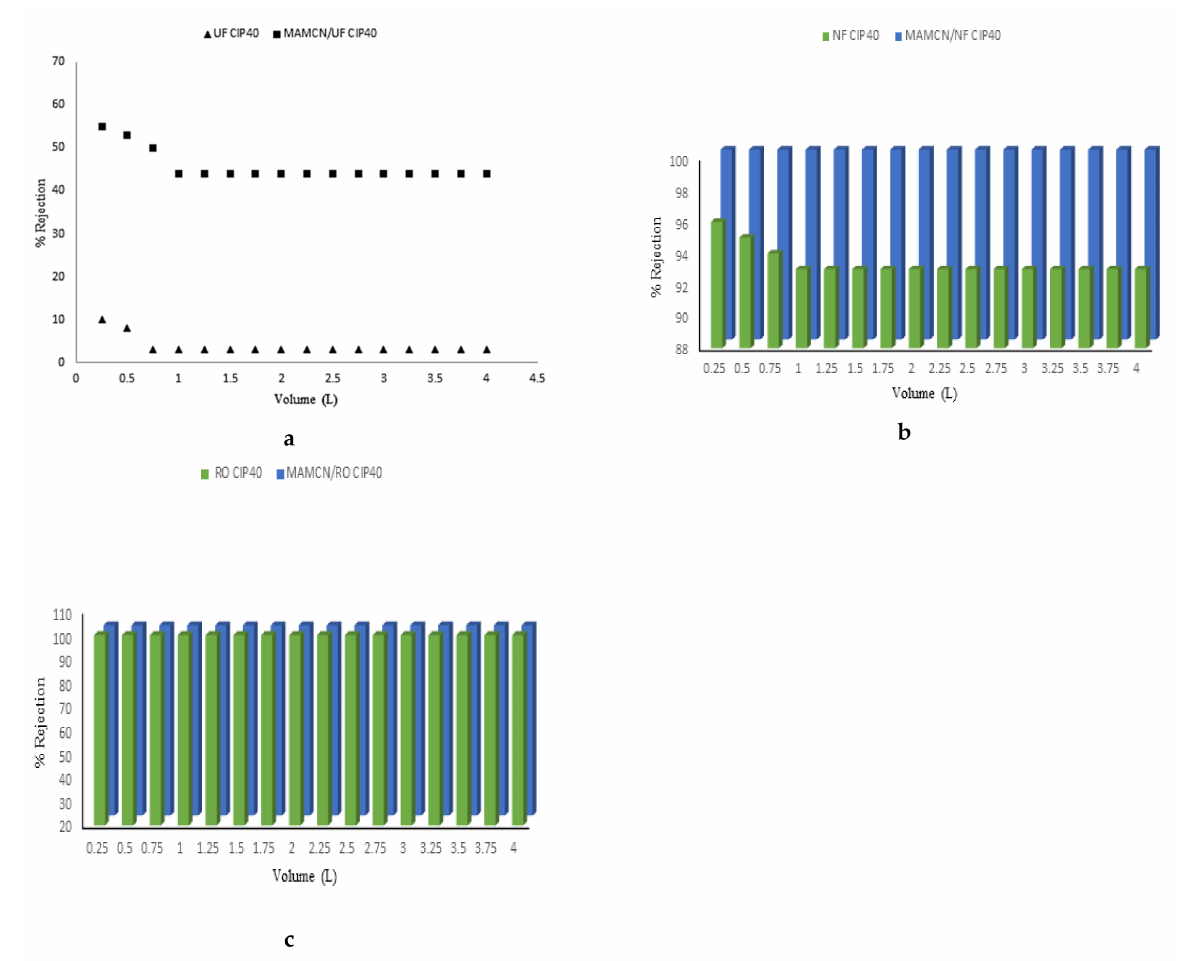
Figure 7. ( a ) Percent rejection of the CIPRO with UF membrane and Fe 3 O 4 /C ( b ) Percent rejection of the CIPRO with NF membrane and the Fe 3 O 4 /C / NF ( c ) Percent rejection of the CIPRO with the RO membrane and the Fe 3 O 4 /C /